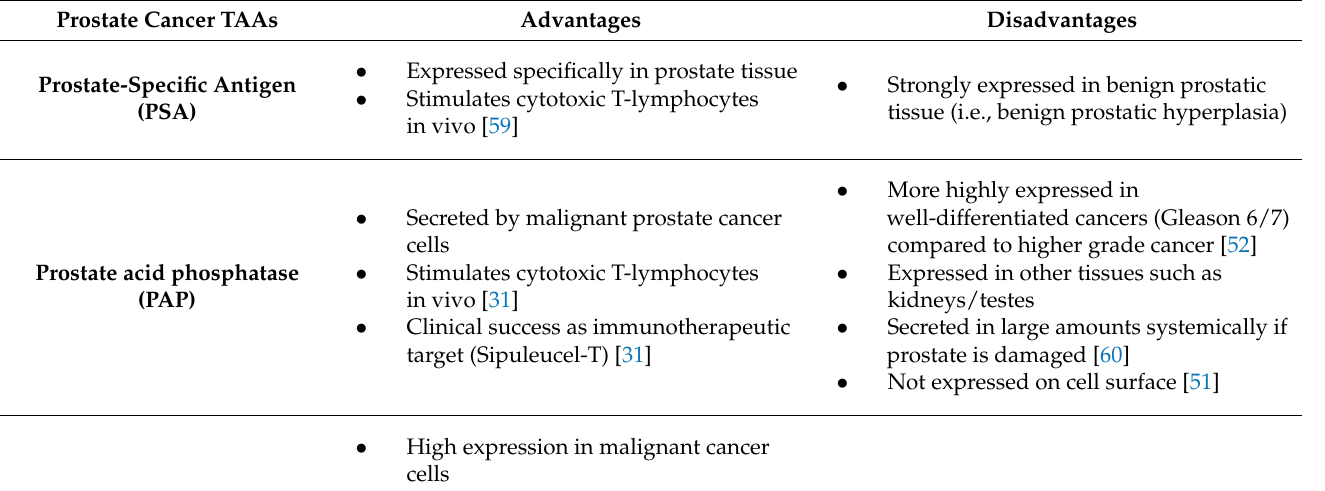
Table 1. Currently studied TAAs in prostate cancer CAR-T therapy, and their associated advantages and